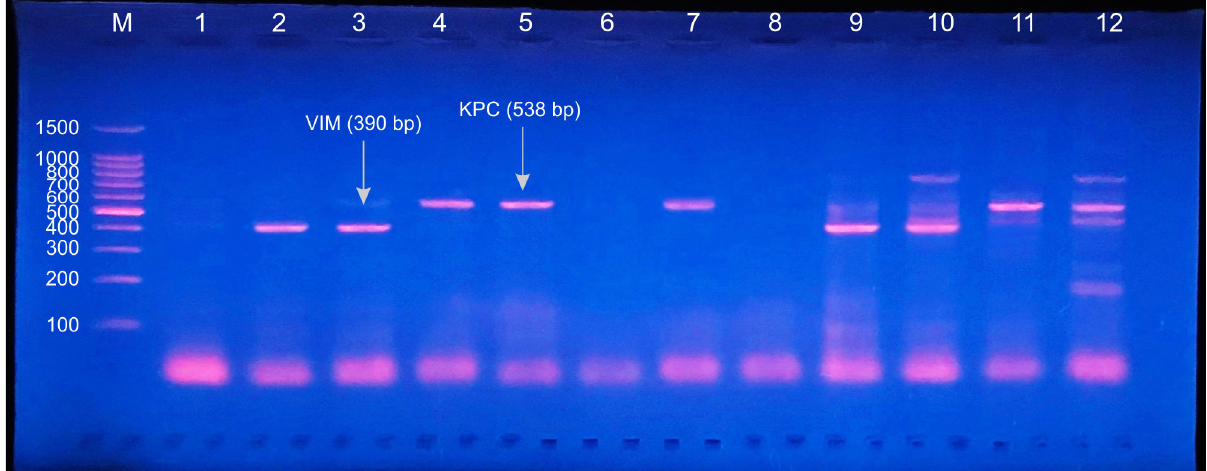
Fig 2. Gel electrophoresis of PCR amplified products for detection of carbapenemases genes: Multiplex III. Multiplex III: bla IMP (139 bp), bla VIM (390 bp) and bla KPC (538 bp). Lane m: DNA Ladder (100 pb); Lanes 1, 6 and 8: negative results for bla IMP , bla VIM and bla KPC ; Lanes 2, 3, 9 and 10: positive results for bla VIM ; Lanes 4, 5, 7, 11, and 12: positive results for bla KPC .